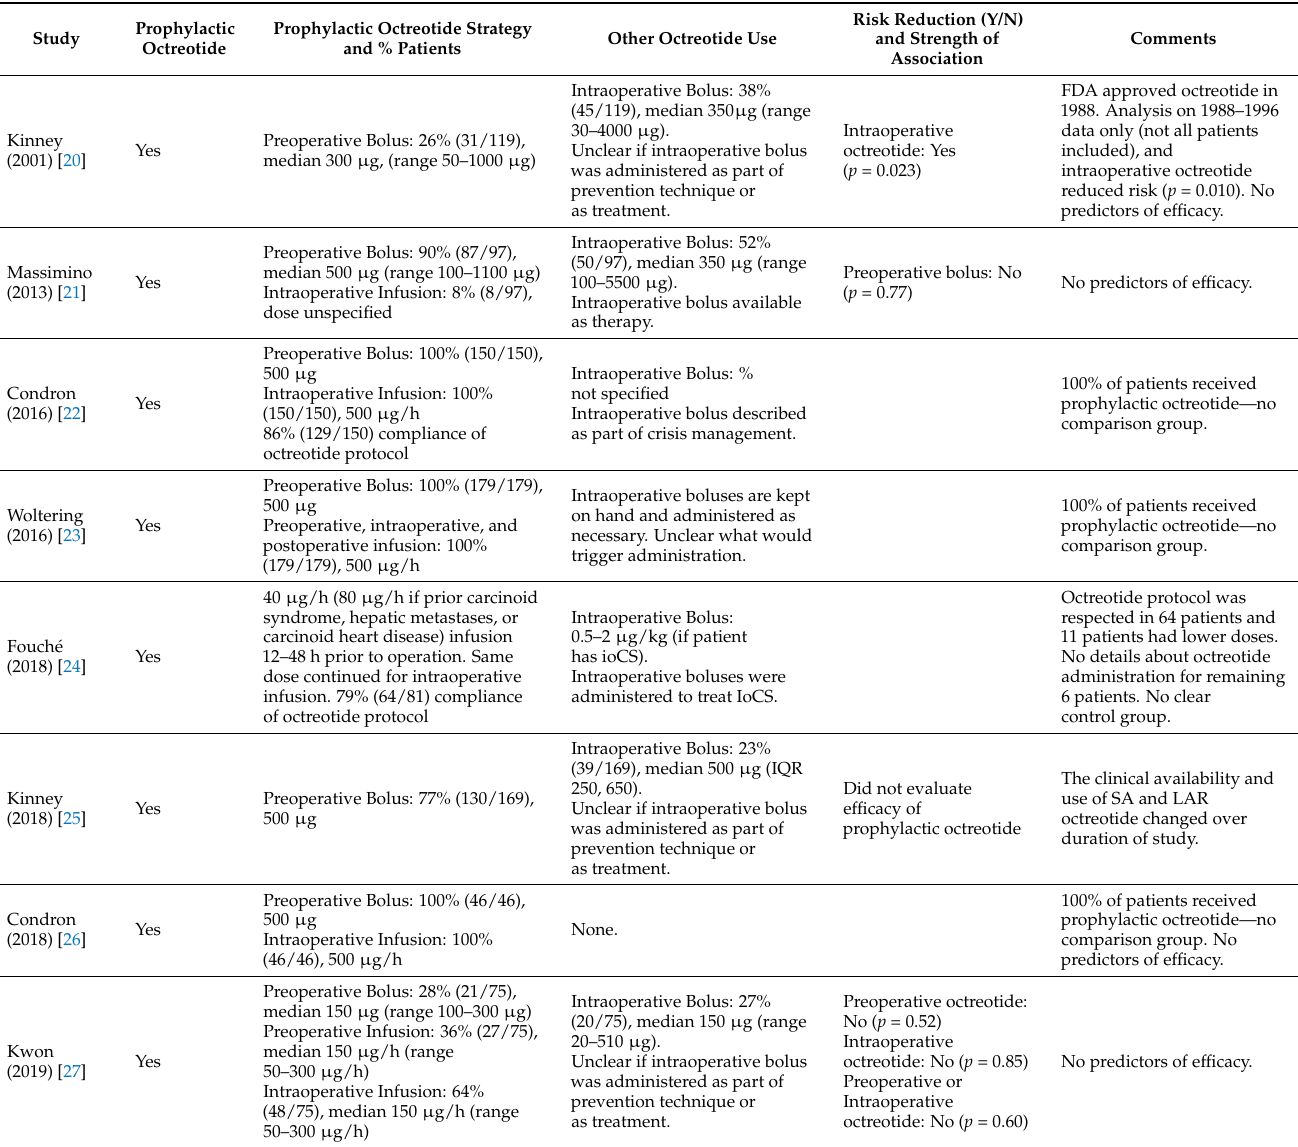
Table 3. Prevention of carcinoid crisis with